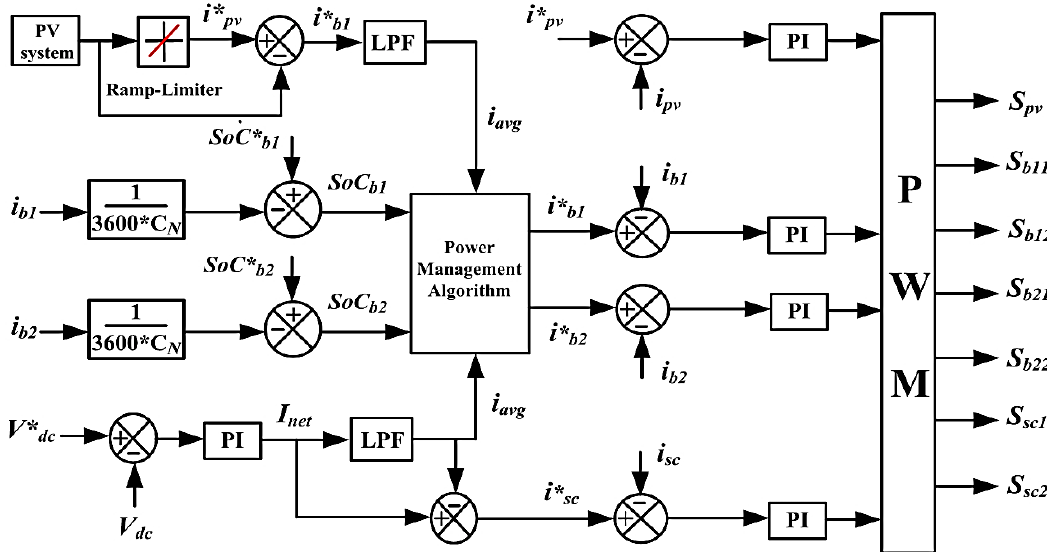
Figure 9. Control configuration of the proposed system.